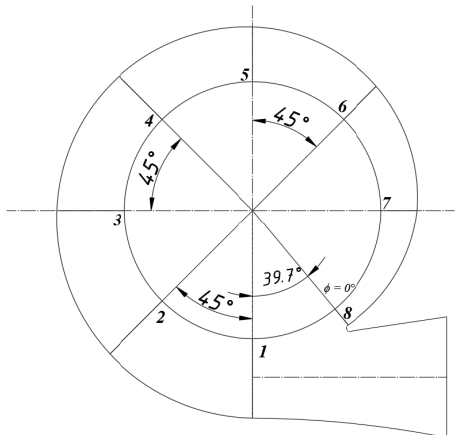
Figure 5. Radial sections of a volute inlet pipe.